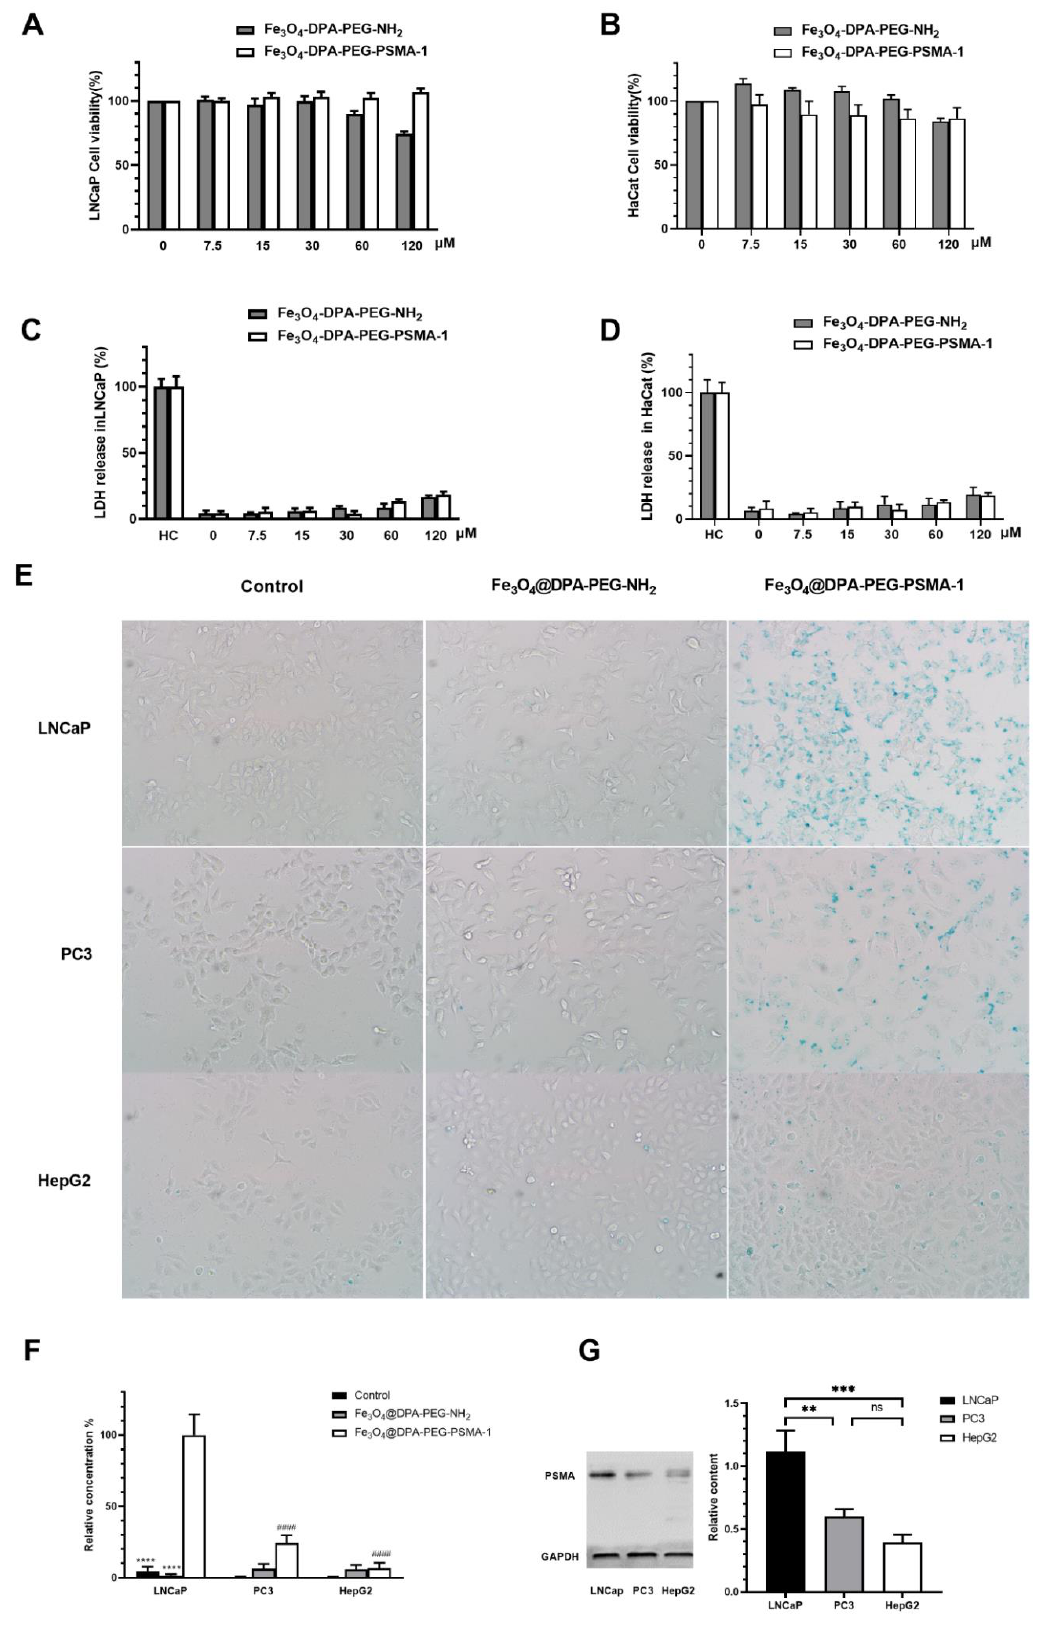
Figure 4. Cell viability of LNCaP ( A ) and HaCat ( B ) by the MTT assay after incubation with different concentration (Fe, µ g/mL) of Fe 3 O 4 @DPA-PEG-PSMA-1 and Fe 3 O 4 @DPA-PEG-PSMA-1 for 48